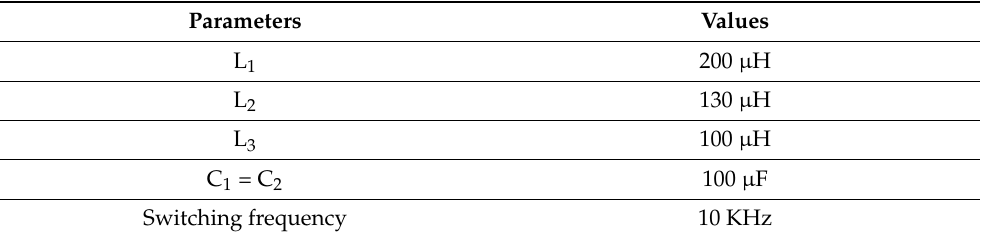
Table 1. Parameters of SCDB